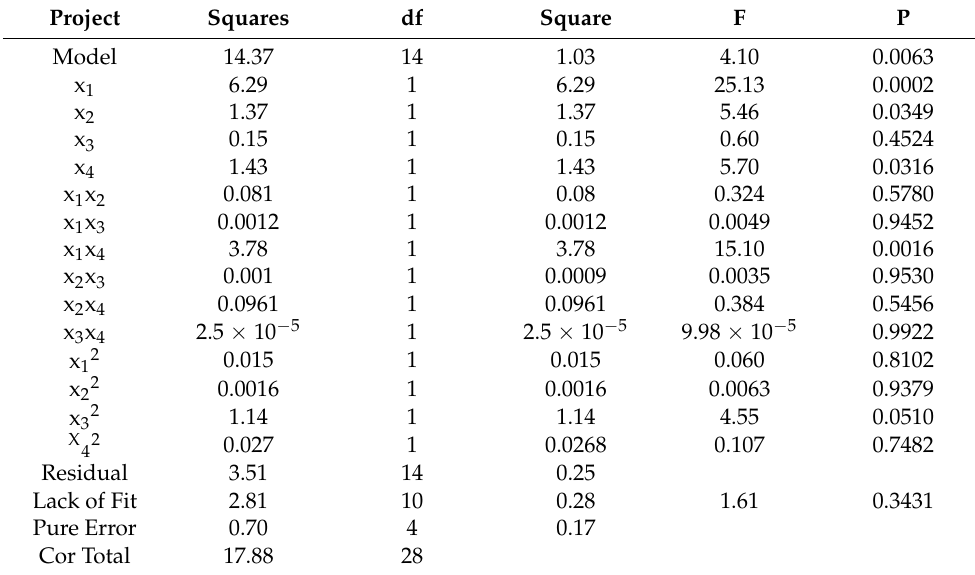
Table 5. Regression model analysis of Variance for Seed